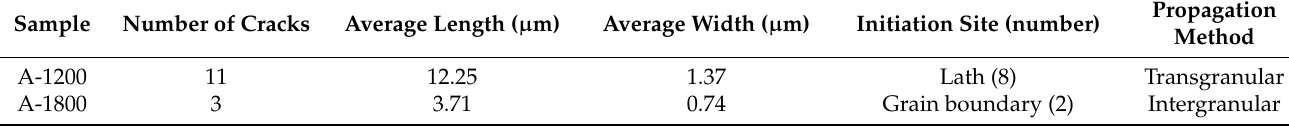
Table 3. Features of cracks for the hydrogen-charged samples.